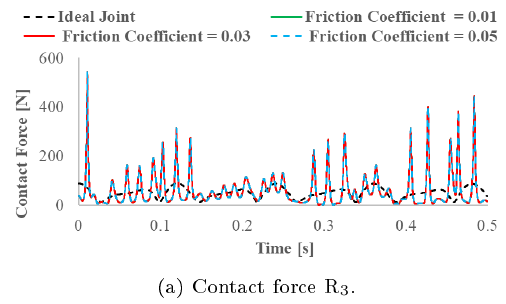
From the simulation results demonstrated ve- locities, accelerations of two sliders, two con- necting rod and the contact force in revolute clearance joints is not a(cid:27)ected by friction which a(cid:27)ecting by gap because friction coe(cid:30)cient in- (b) Contact force R 4 . crease from 0.01 to 0.05, the graph of velocities, acceleration and contact force are the same each Fig. 12: Contact force at di(cid:27)erent friction coe(cid:30)cient.